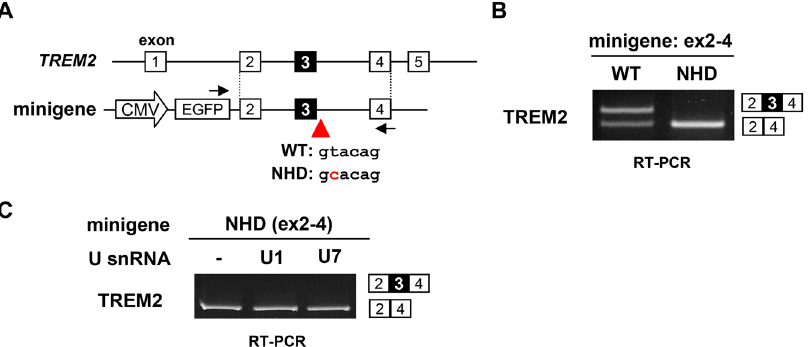
Figure 1. NHD minigene shows exon 3 skipping. ( A ) Schematic diagram of the TREM2 exon 2–4 minigene. The minigene is inserted downstream of the EGFP cDNA. The positions of the primer set used to detect splicing are indicated by arrows. A red arrowhead indicates the position of the 5 ′ splice site mutation (c.482 + 2 T > C) found in NHD. ( B ) Splicing assay of WT and NHD minigenes transfected into HEK cells. Splicing patterns were detected by RT-PCR using the primer set indicated in ( A ). ( C ) Unmodified U1 and U7 snRNAs did